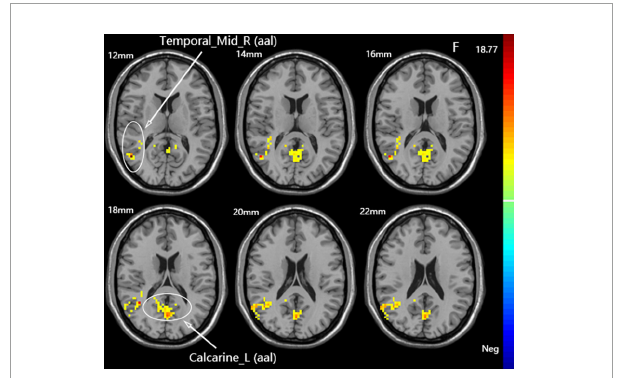
FIGURE4 Statistical maps showing fALFF difference after iTBS among the three groups. The color bar indicated the F -values of the ANOVA analysis.